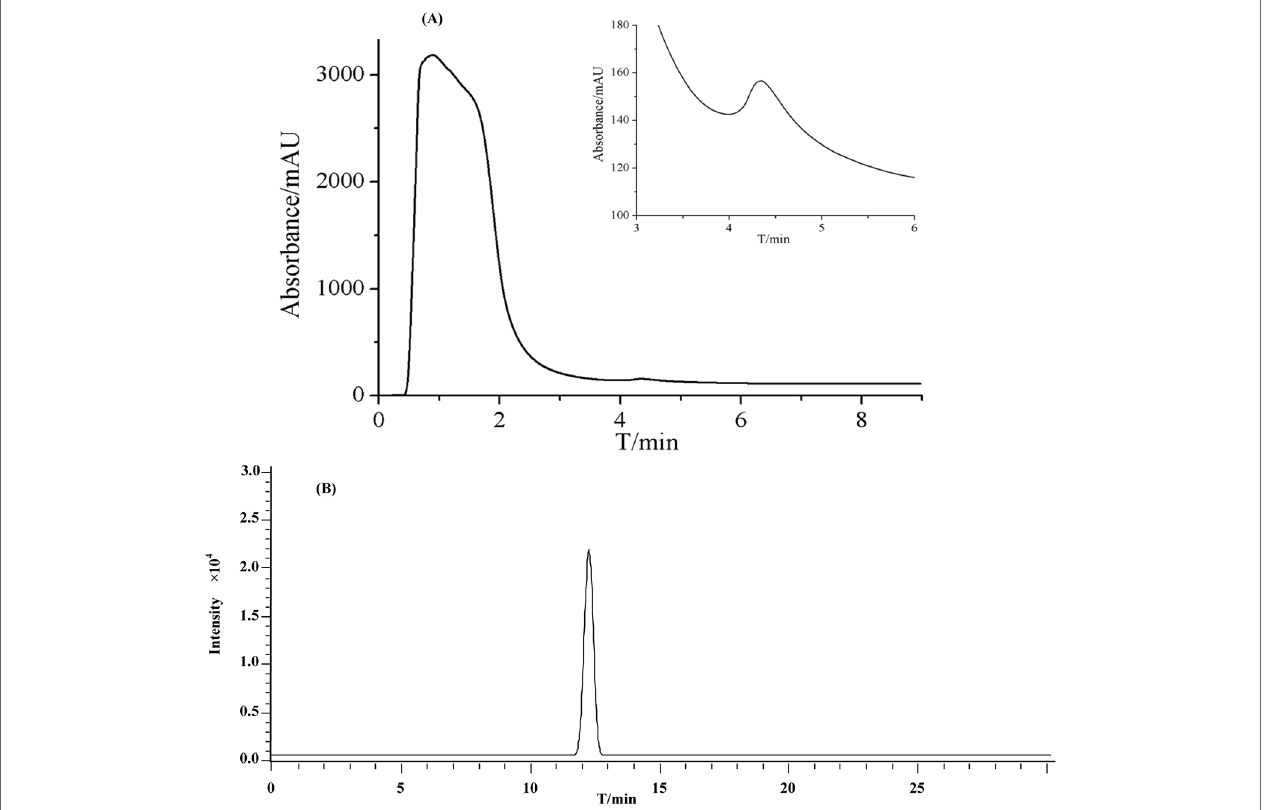
FIGURE 4 | Representative chromatograms of (A) LHG extract on the β 2-AR column. (B) Total ion current of eluted compounds by reversed-phase high- performance liquid chromatography coupled with mass